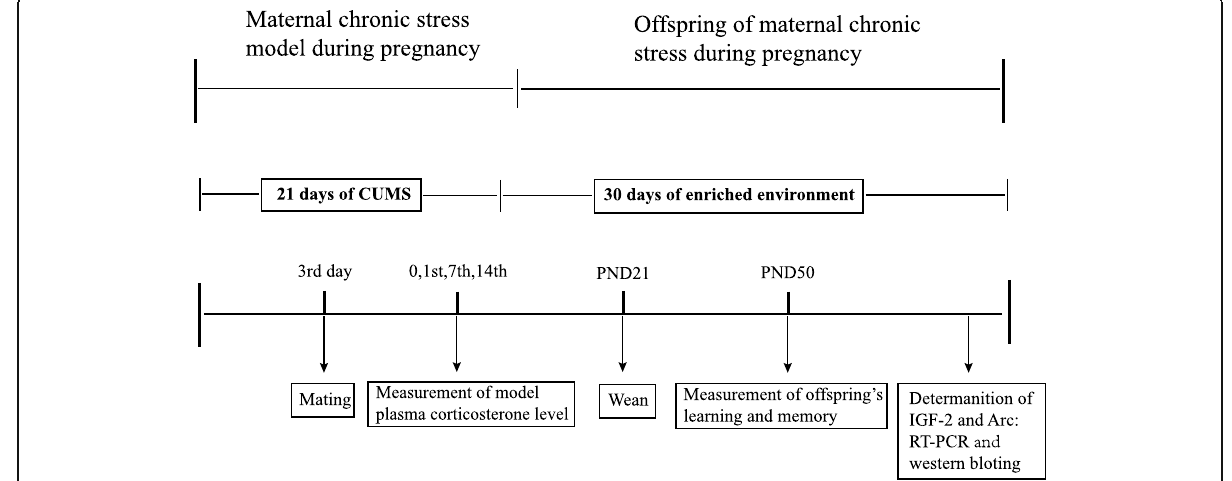
Fig. 1 Experimental procedure of learning and memory of the offspring under maternal chronic stress rat during